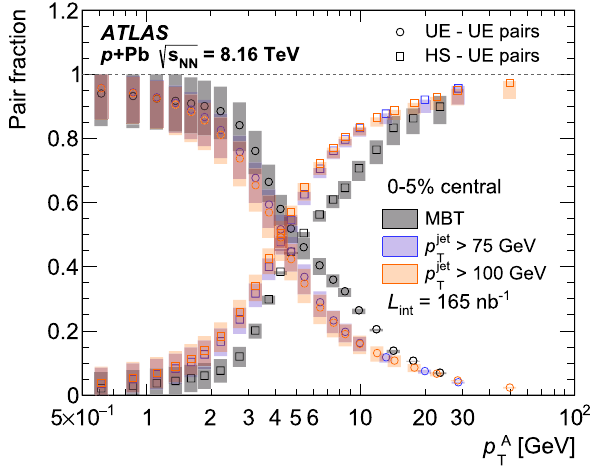
Fig. 11 Underlying event–underlying event (UE–UE) (open circles) and hard scatter–underlying event (HS–UE) (open squares) particle- pair yield composition fractions for MBT events (black), events with jet p T > 75GeV(blue),andeventswithjet p T > 100GeV(orange)plotted as a function of the A-particle p T . Statistical uncertainties are shown as narrow vertical lines on each point, and systematic uncertainties are presented as coloured boxes behind the